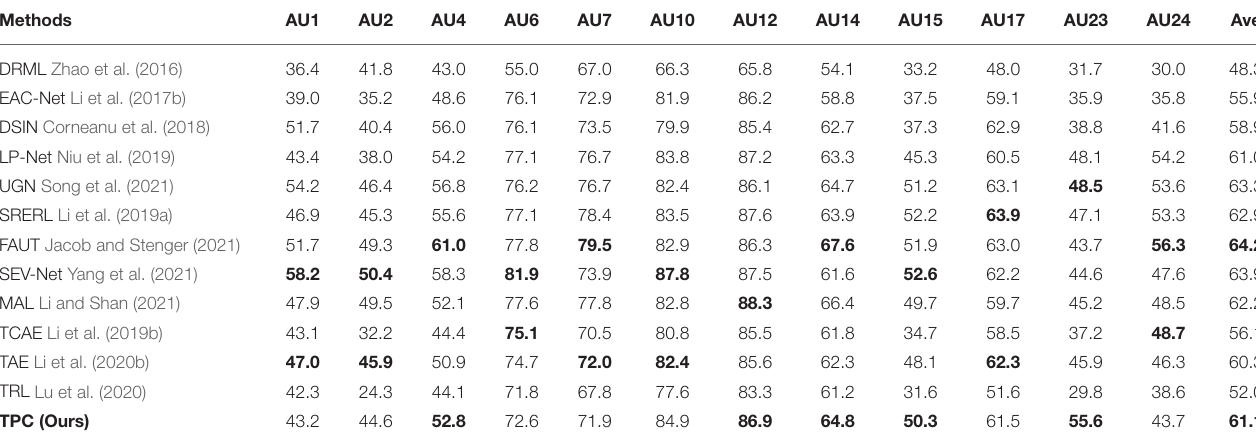
TABLE 1 | Action unit (AU) detection accuracy of the proposed temporally predictive coding (TPC) and state-of-the-art approaches on BP4D dataset. Methods